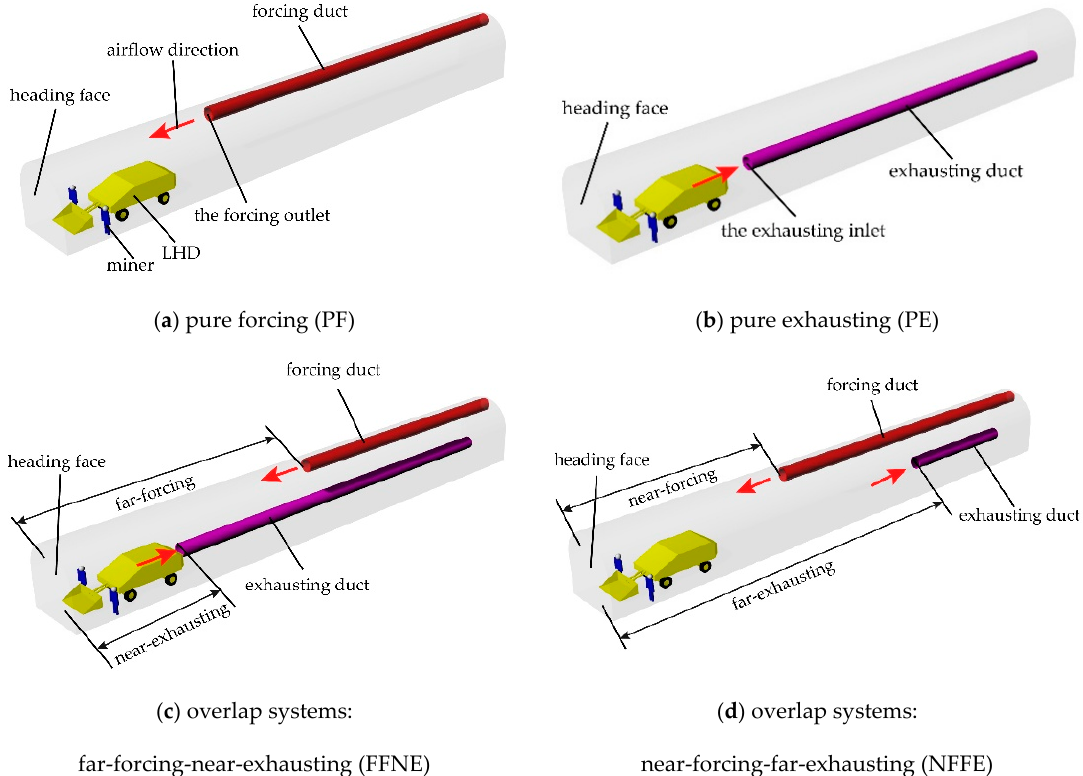
Figure 1. Geometry model of the PF ( a ), PE ( b ), FFNE ( c ), and NFFE ( d ) ventilation systems.